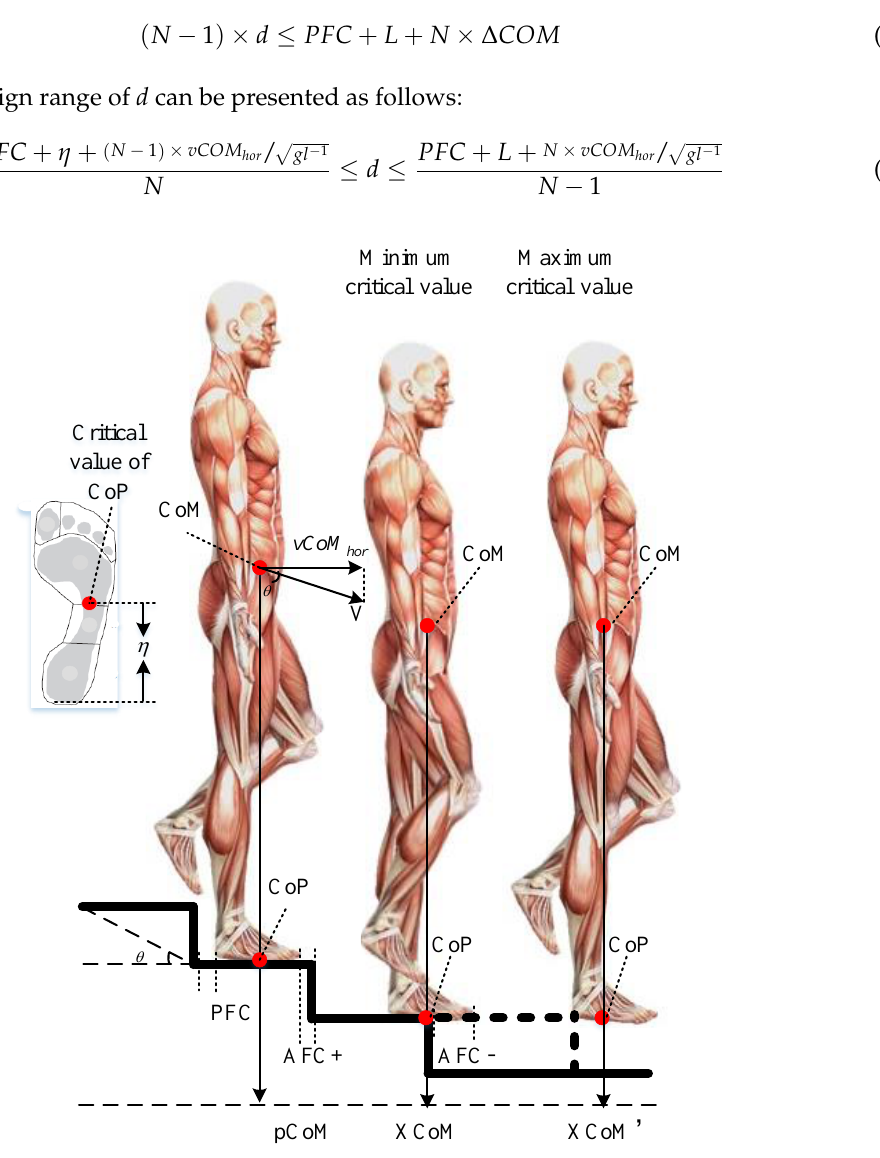
Figure 3. Inverted pendulum model while descending the staircase. Three discrete states to step down onto the next step are described, showing the vertical projection of the CoM, the horizontal initial velocity of the COM, the different conditions of PFC and AFC, and the tilt angle of the staircase. The middle posture repents the risk state and the minimum critical value of SDP. The right posture represents the maximum critical value of SDP.